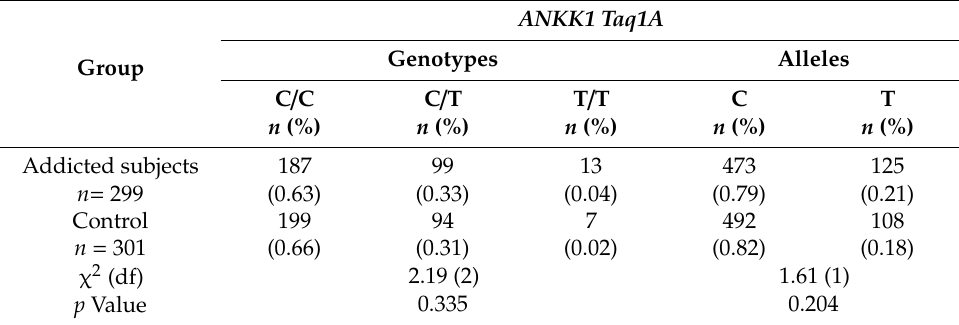
Table 3. Frequency of genotypes and alleles of the ANKK1 Taq1A gene polymorphisms in addicted subjects and